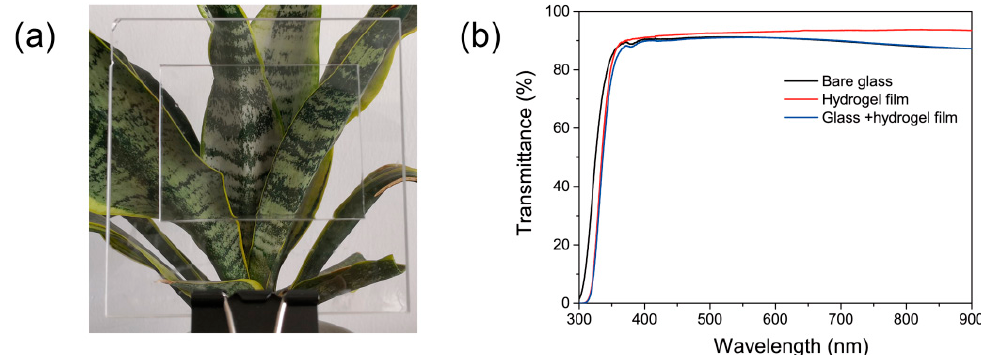
Figure 7. ( a ) Digital photograph of the PAS gel-coated glass plate; ( b ) UV–Vis transmission spectra of bare glass, hydrogel film, and the hydrogel-coated glass plate.